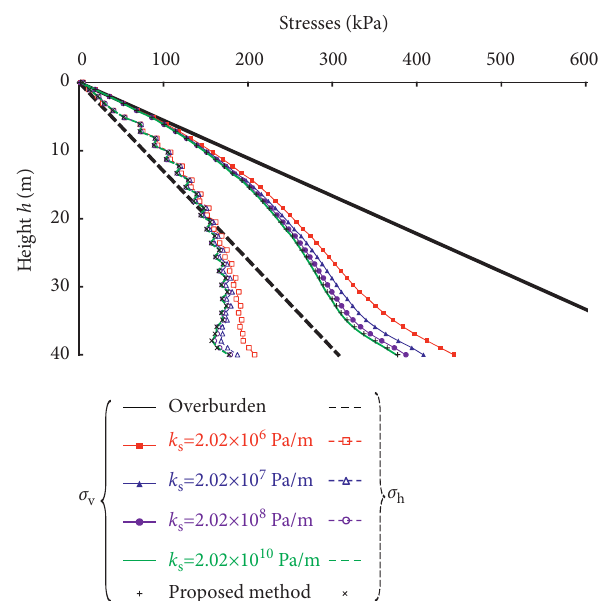
Figure 6: Vertical ( σ v ) and horizontal ( σ h ) stresses plotted along VCL of stopes with different shear stiffness (k) s of interfaces in upward cut and fill